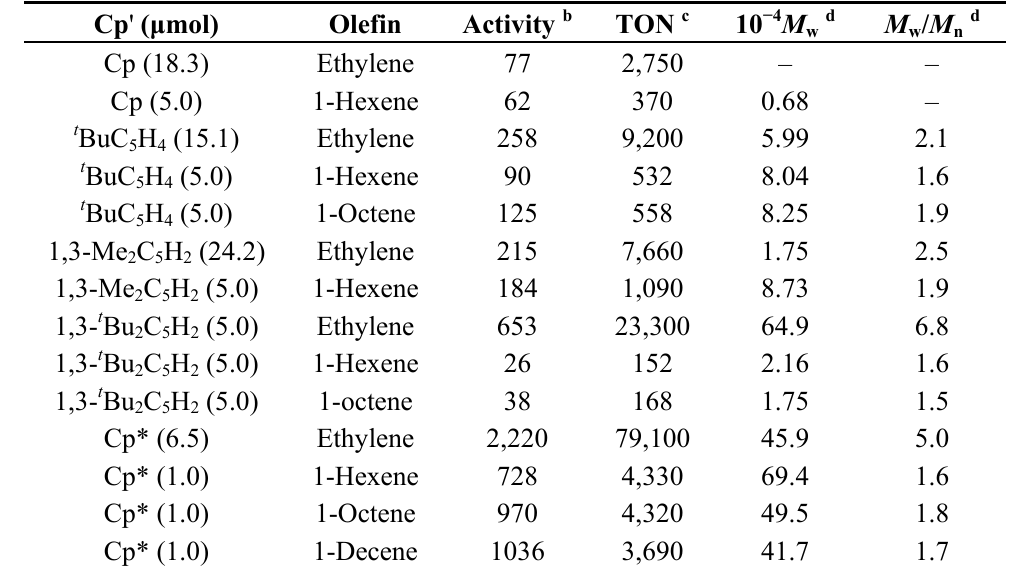
Table 3. Effect of cyclopentadienyl fragment (Cp') on the activity of olefin